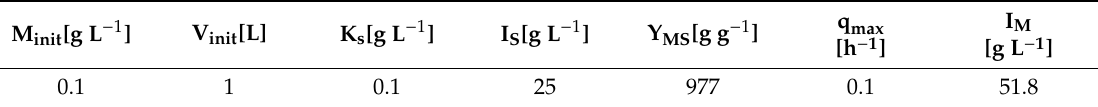
Table A16. Initial concentrations for metabolite M init and volume V init . Model parameters for monod constant substrate K S , substrate inhibition constant I S , yield coe ffi cient metabolite / substrate Y MS , maximum production rate metabolite q max , and metabolite inhibition constant I M . Parameters estimated by adaptation to previous experiment.